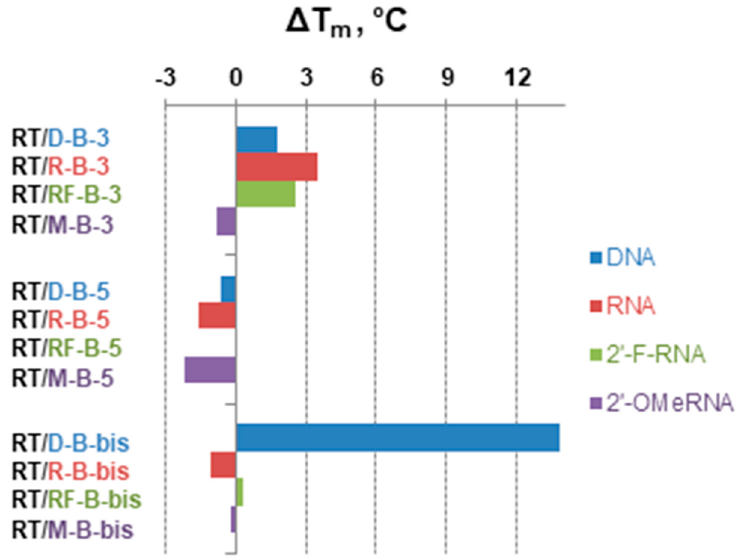
Figure 7. The differences between T m values for duplexes formed by non-modified parent oligonu- cleotides and by corresponding closo -dodecaborate conjugates with RNA target RT .